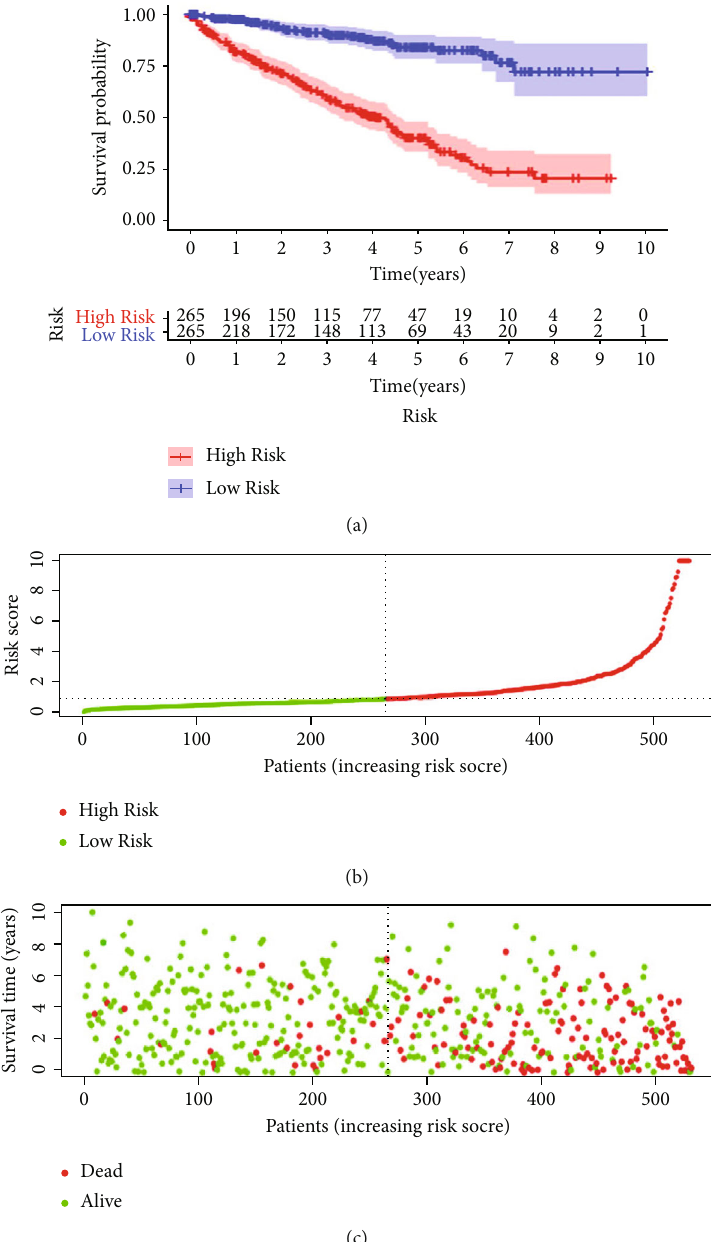
Figure 2: The autophagy-related prognostic model on the patients of ccRCC. (a) The Kaplan-Meier curve revealed a fact that the high-risk group came in a shorter OS value than the low-risk one. (b) Prognostic model distribution on the patients of ccRCC. (c) OS value of patients in the TCGA dataset. The region of red color indicated a higher risk score whereas the green color meant lower